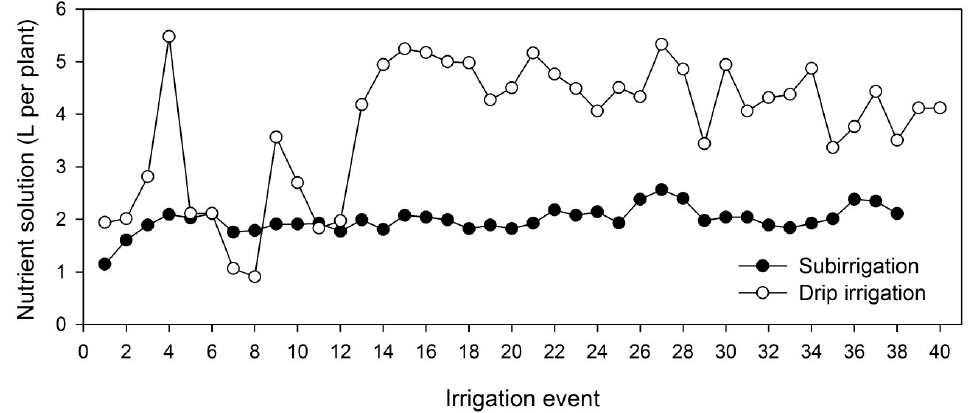
Figure 2. Volume of nutrient solution required at every irrigation event to bring the growing medium to container capacity in containerized tomato ( Solanum lycopersicon L.) plants.